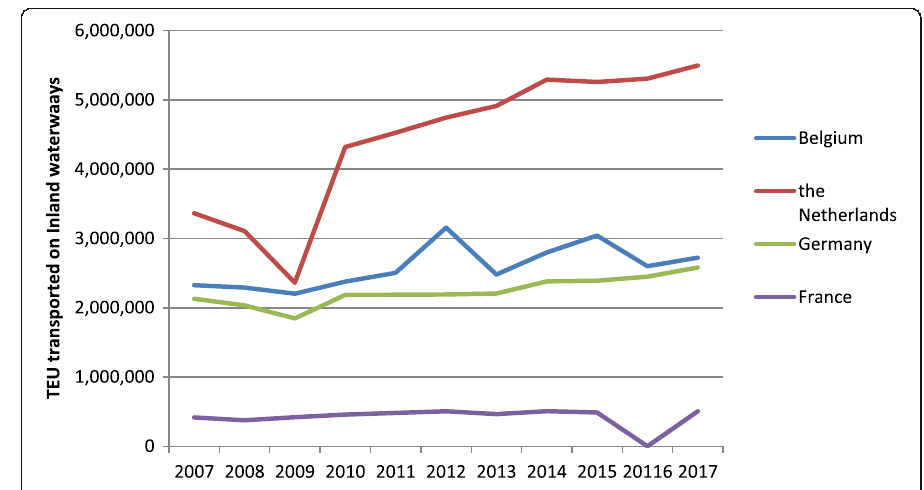
Fig. 2 Developments in inland container shipping in Western Europe (in TEU). Source: Author ’ s own compilation, based on EUROSTAT